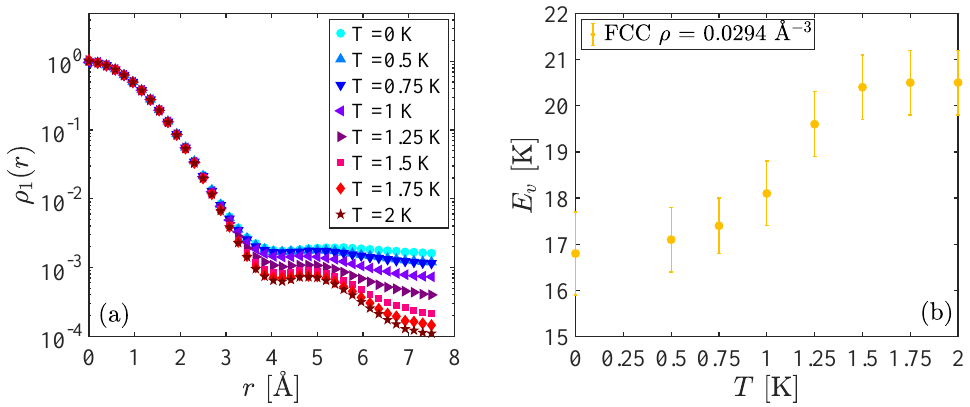
Figure 1. Results for a fcc crystal at density ρ = 0.0294 Å − 3 : ( a ) one-body density matrix ρ 1 ( r ) as a function of the interatomic distance r , for different values of the temperature T (error bars are below symbol size); and ( b ) vacancy formation energy E v as a function of the temperature.